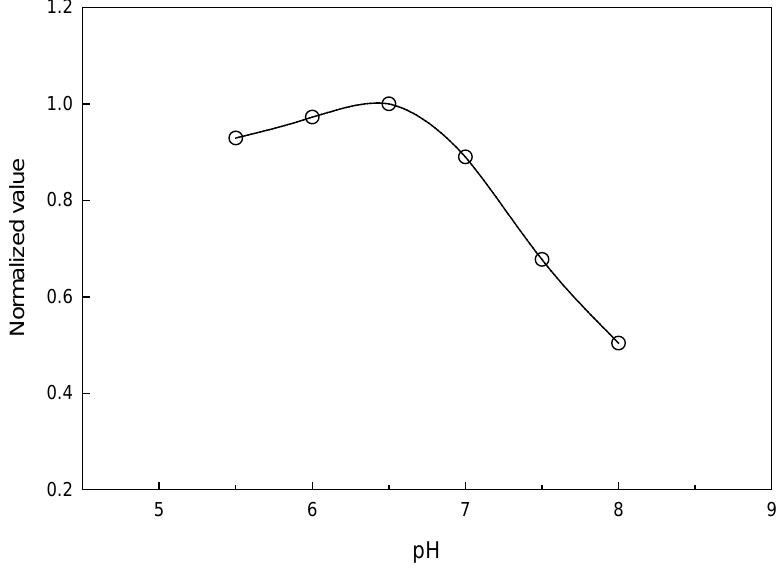
Figure 7. pH profile of NiR and CHIT-V co-immobilized GCE in 0.1 M phosphate buffer under argon. Catalytic reduction currents for 1 × 10 −3 M of nitrite at scan rate of 0.002 V/s were